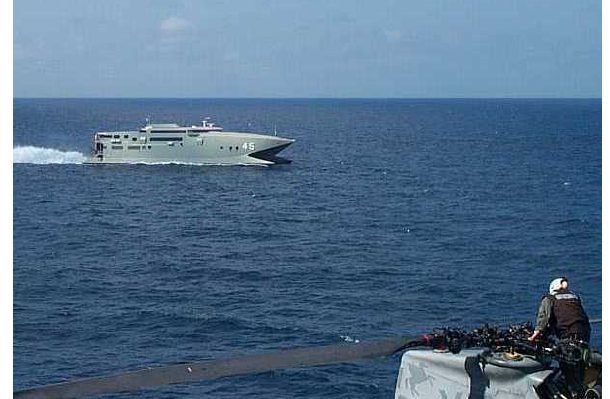
Figure 11. The HMAS Jervis Bay in